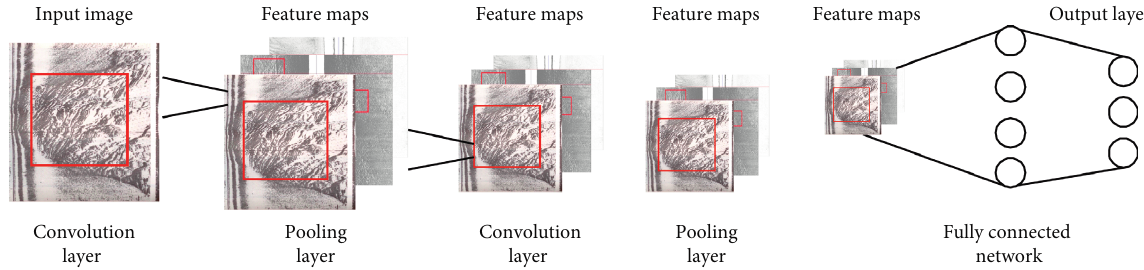
Figure 1: Schematic diagram of convolution neural network operation.